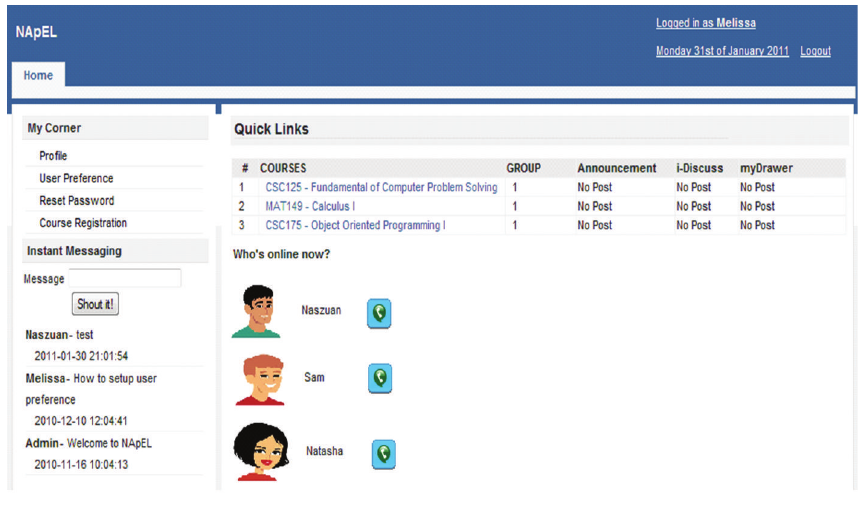
Figure 3: NApEL user interface. We have integrated Skype into NApEL. Each Skype user on a PC, notebook, or PDA can send messages to other Skype users and check online or o ffl ine presence of these users in real time.